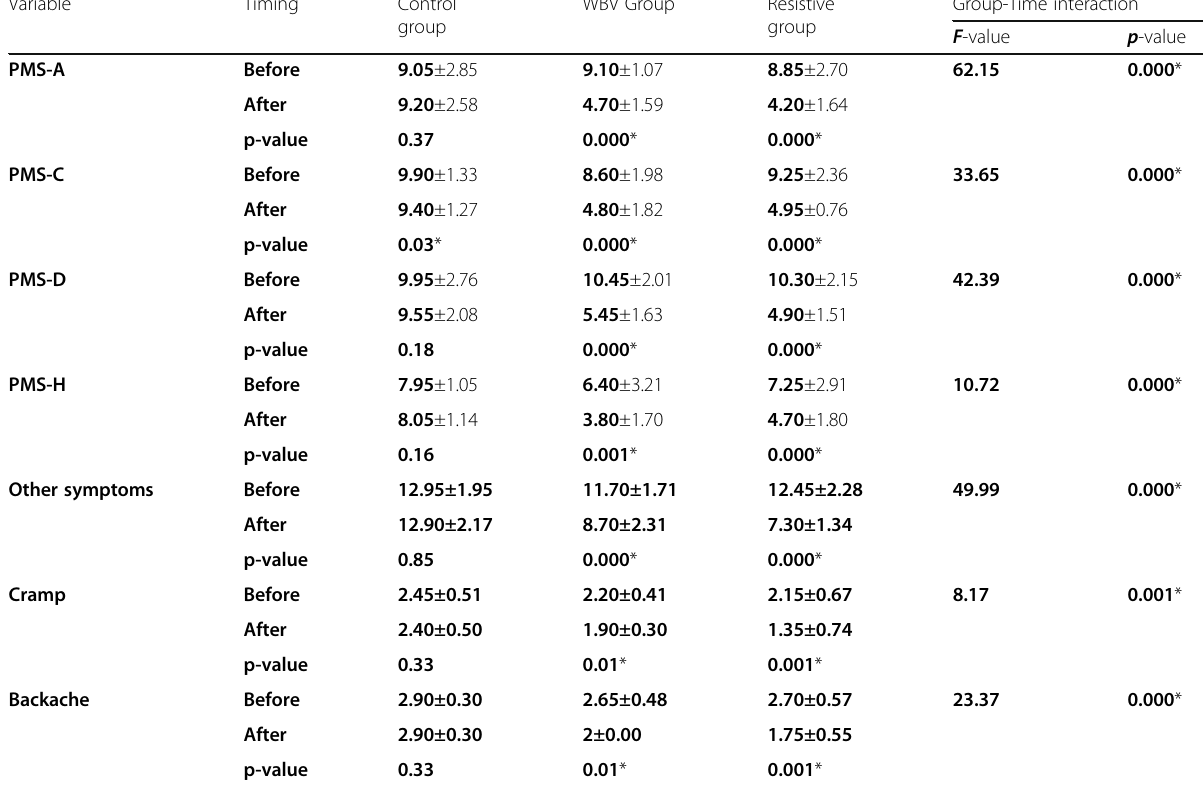
Table 2 The mean and standard deviation of PMS symptoms for all groups